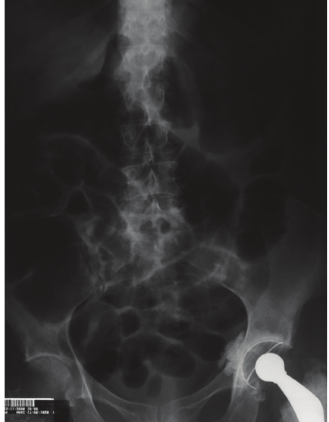
Figure 2: Abdomen radiograph showing the presence of high level of air fluid in the bowel loops.